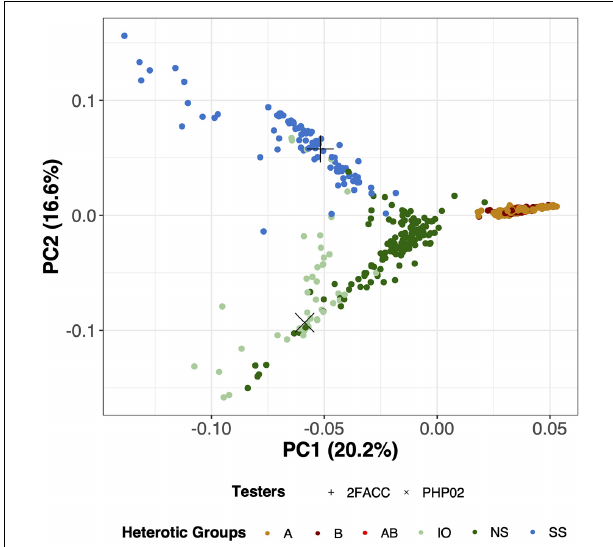
FIGURE 3 | Principal component analysis (PCA) for 533 inbred lines in this study using 755,339 Single Nucleotide Polymorphisms (SNPs). PC1 (x-axis) explains 20.2% of the variation of the SNP data while PC2 (y-axis) explains 16.6% of the variation of the SNP data. Testers in this experiment (2FACC and PHP02) are individually labeled with distinct shapes while heterotic groups are differentiated based on color. A, B, and AB are DTMA heterotic groups, while Iodent (IO), Non-Stiff Stalk (NS), and Stiff Stalk (SS) are temperate heterotic